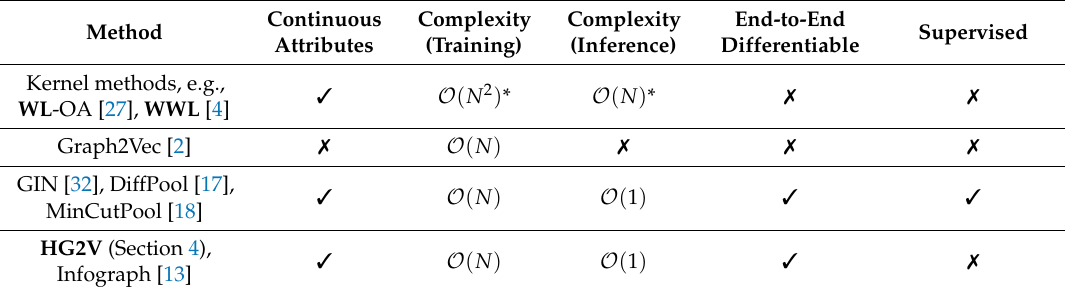
Table 1. Key properties of methods (related or proposed) for graph embedding. N is the number of graphs. Symbol (cid:55) for complexity (inference) means the method is transductive (and not inductive) and one needs to use the same time as for training. Symbol (cid:51) for supervised means labels are required to learn a representation (by back-propagating classification